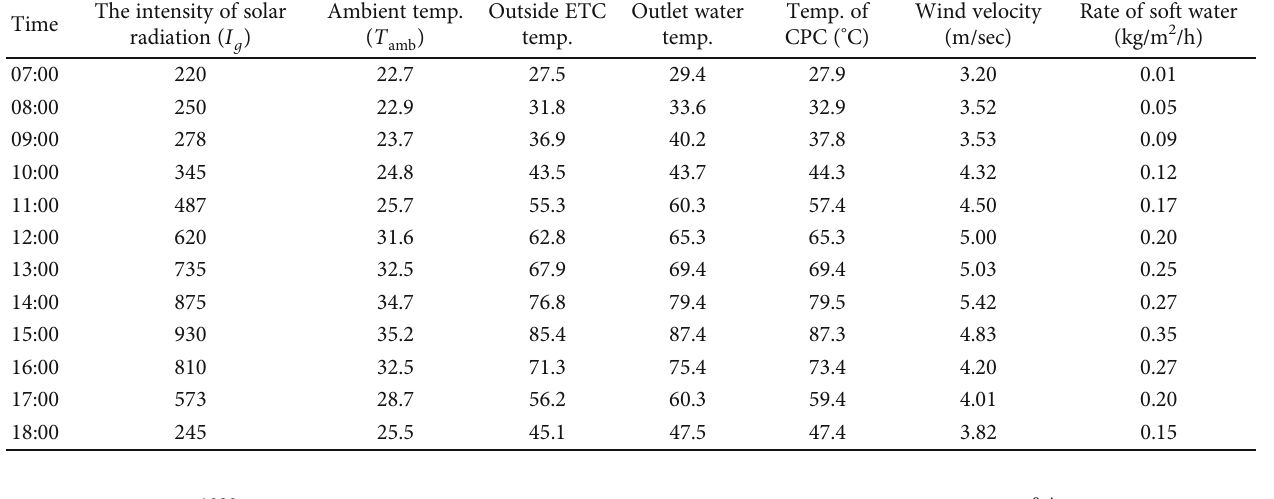
Table 2: Hourly variations of measured parameters in May 2018 with Al foil material of CPC.